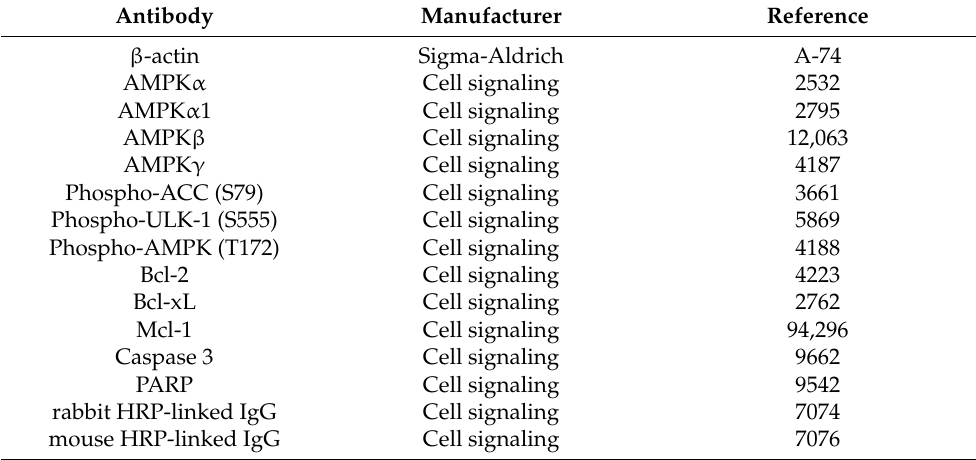
Table 2. Antibodies used for Western